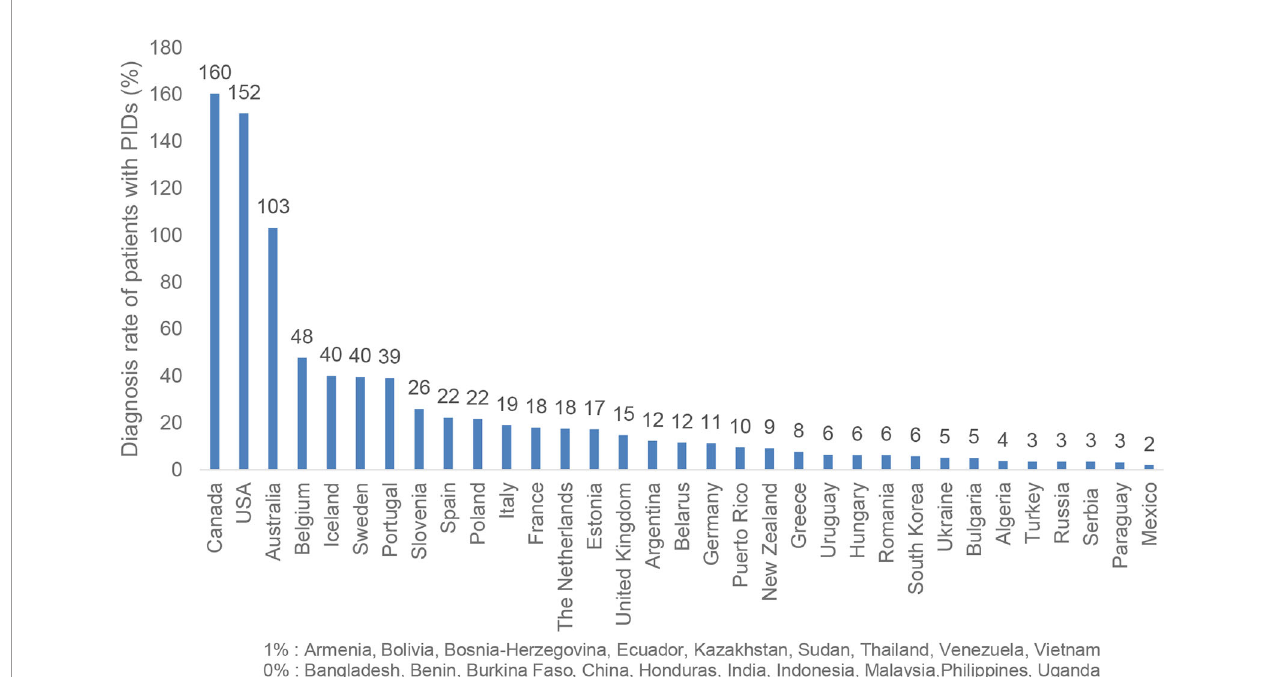
FIGURE 1 | Diagnosis Rate of PIDs per National Population* (n=52). * Countries such as Canada, the United States and Australia calculate the number of patients with PIDs based on higher prevalence that includes even asymptomatic antibody de fi ciencies (IgA) which is not the case in the rest of the world. This explains the score above